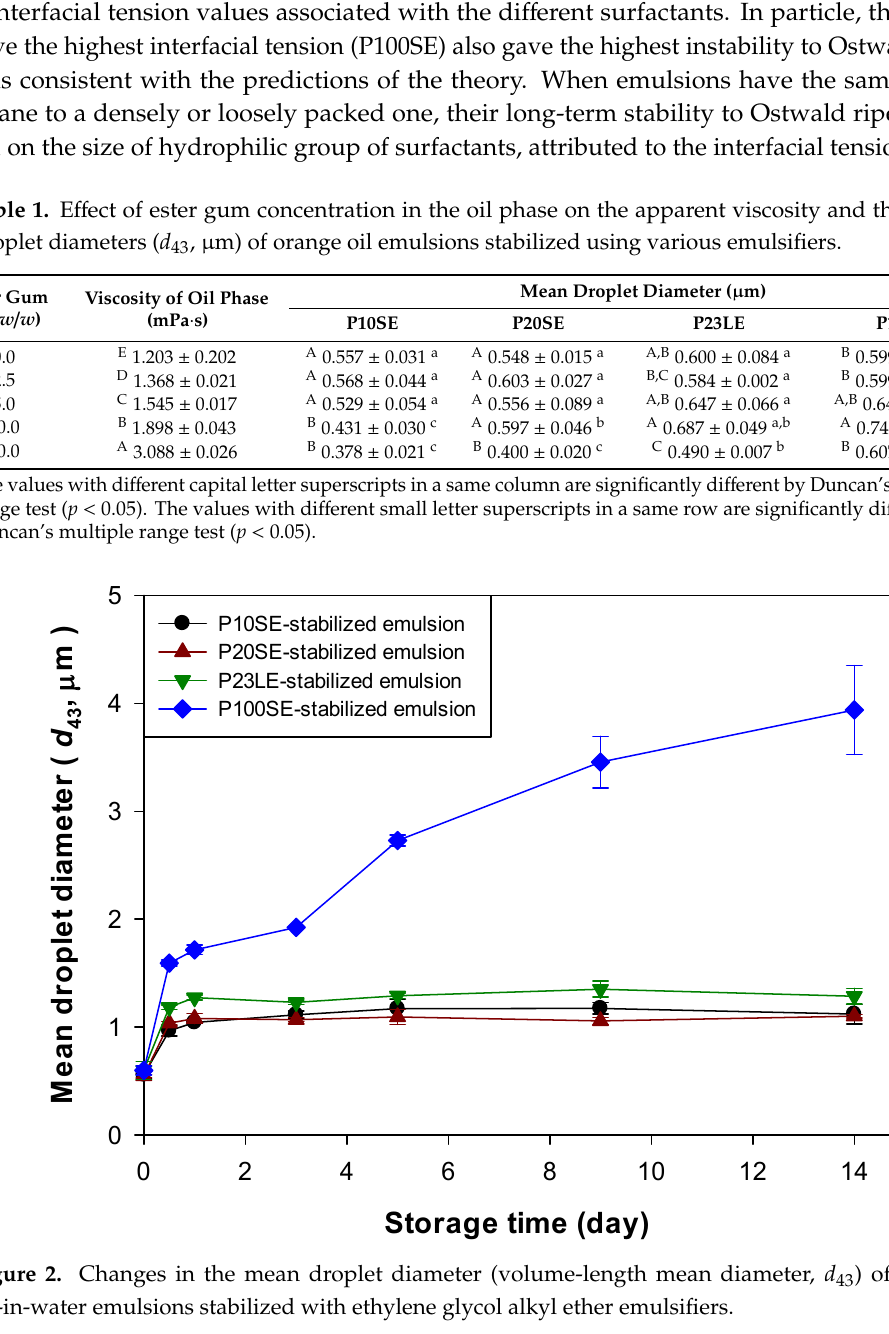
Table 1. Effect of ester gum concentration in the oil phase on the apparent viscosity and the initial droplet diameters ( d 43 , µm) of orange oil emulsions stabilized using various emulsifiers.